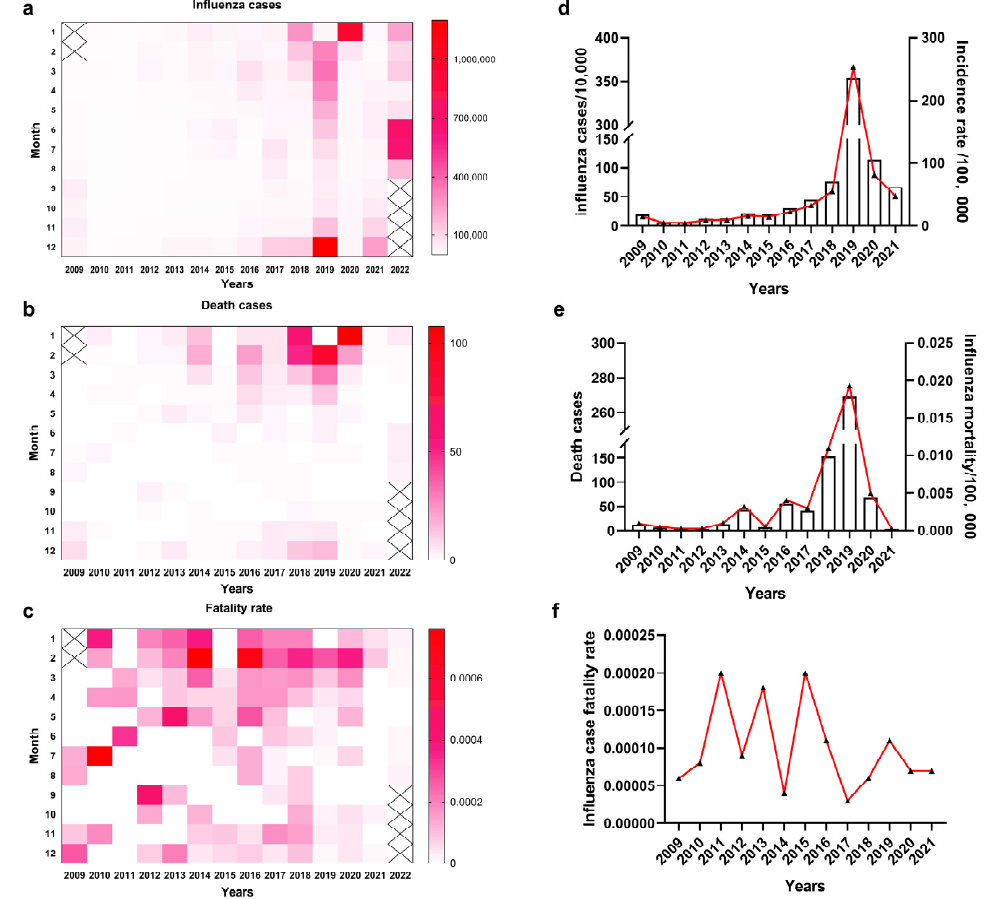
Figure 1. Analysis of monthly influenza infections from March 2009 to August 2022 and annual influenza infections from 2009 to 2021. ( a ) Monthly influenza infection from March 2009 to August 2022. ( b ) Monthly influenza deaths from March 2009 to August 2022. ( c ) Monthly influenza case fatality rate from March 2009 to August 2022. ( d ) Annual influenza infection and incidence rate from 2009 to 2021. ( e ) Annual influenza deaths and mortality from 2009 to 2021. ( f ) Annual influenza case fatality rate from 2009 to 2021.